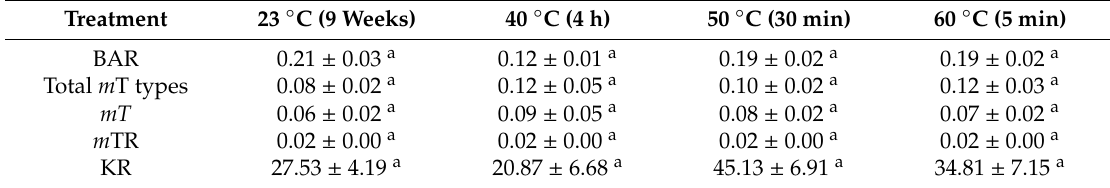
Table 8. Concentration of endogenous aromatic cytokinins (pmol g − 1 FW) of P. halepensis embryogenic masses collected at the end of initiation phase and induced under di ff erent